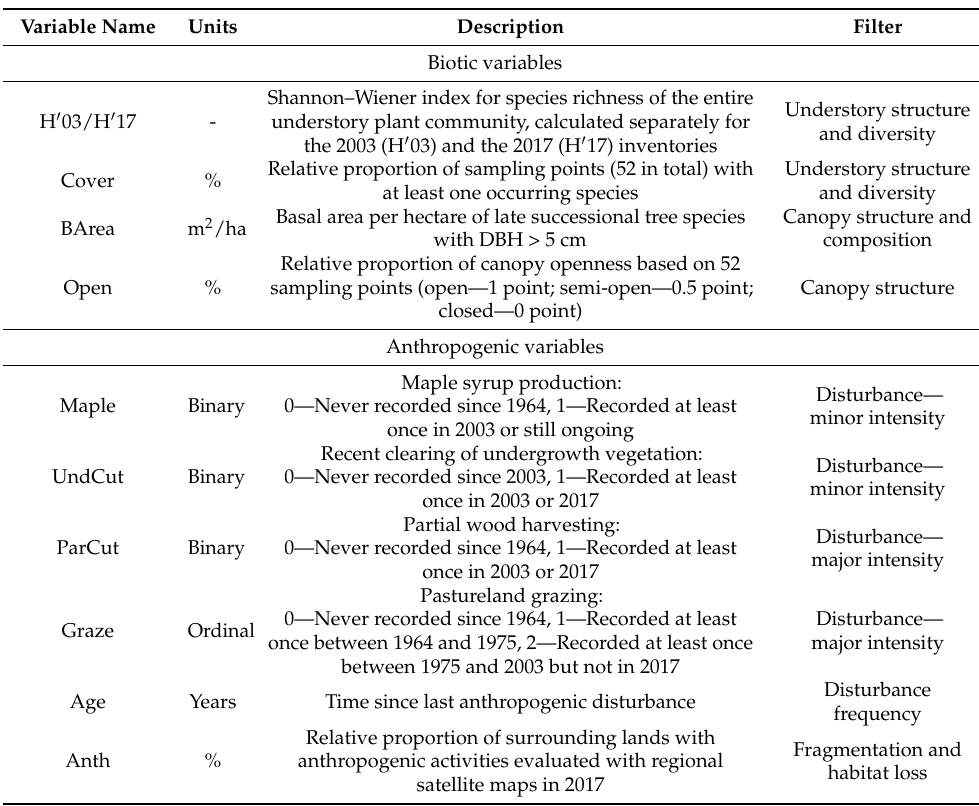
Table 2. Description of the biotic and anthropogenic variables measured or calculated at each stand, as well as the underlying filter associated to each